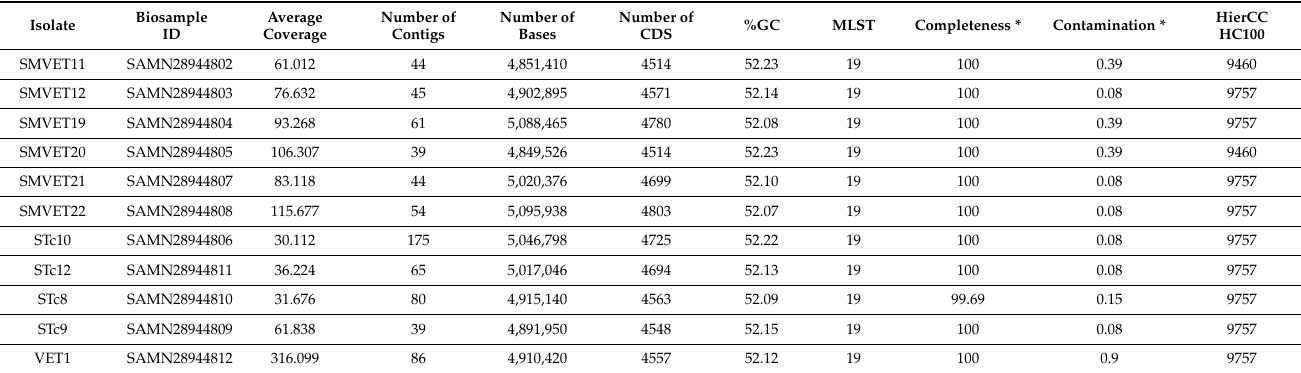
Table 1. Genomic statistics of 11 S. Typhimurium isolates from guinea pigs in Lima,